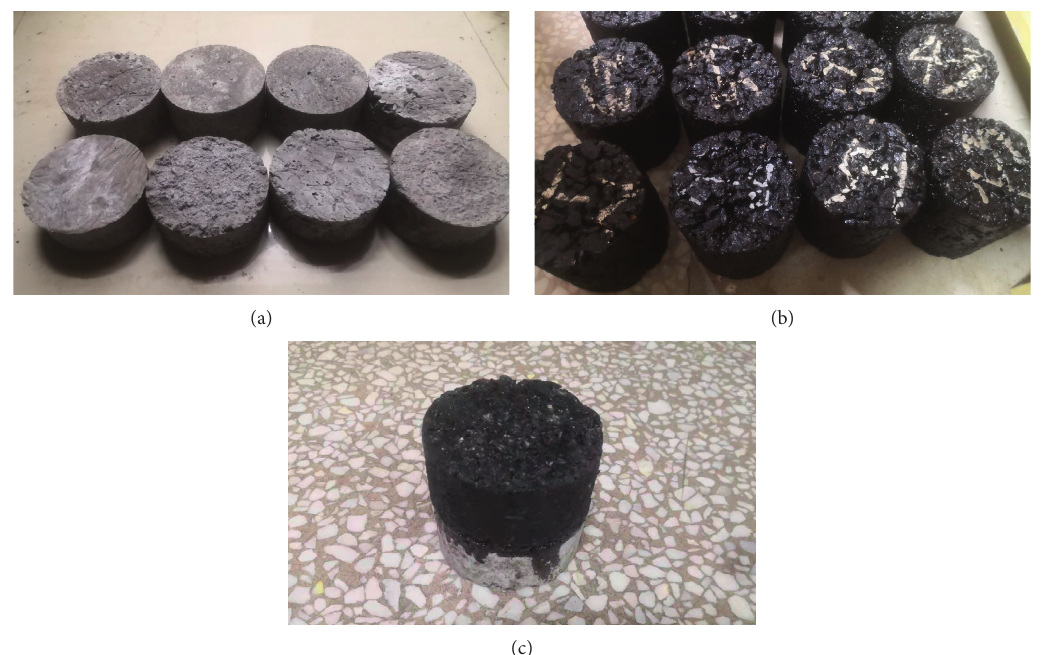
Figure 1: Preparation of the composite specimen. (a) Cement concrete specimens. (b) Asphalt mixture specimens. (c) Composite specimen of the cement concrete-waterproof adhesive layer-asphalt mixture.